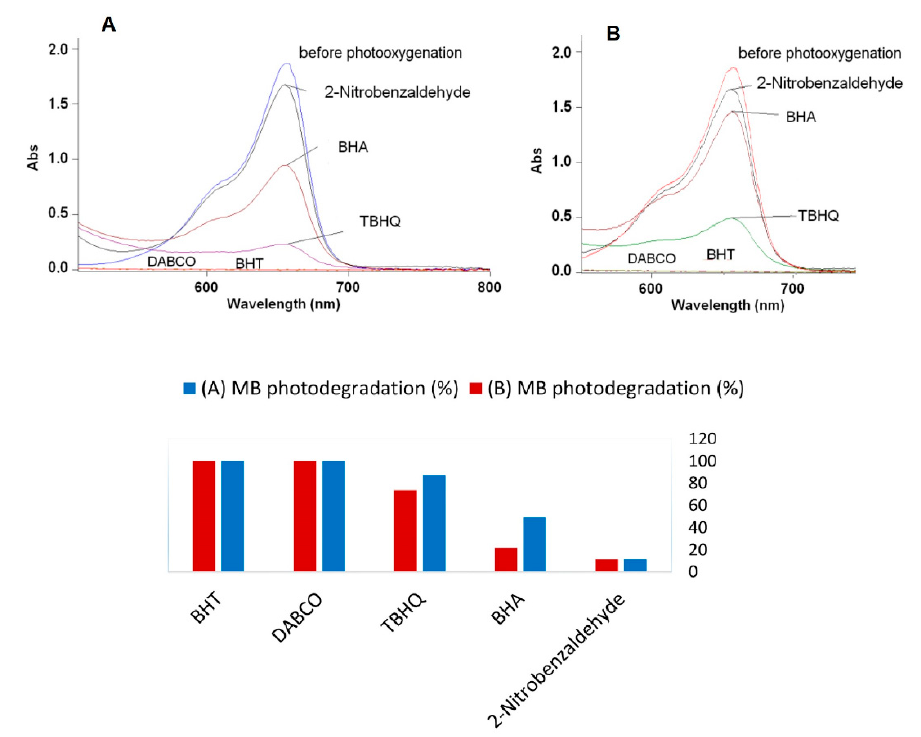
Figure 3. UV-Vis spectra and bar graph showing the degree of photodegradation of MB ( λ max = 655 nm) in the presence of different kinds of antioxidants after 24 h of irradiation with 16 fluorescent lamps ( λ = 300 nm). Antioxidant concentrations: ( A ) 1 mmol DABCO, BHA, BHT, TBHQ, and 2-nitrobenzaldehyde. ( B ) 0.5 mmol DABCO, BHA, BHT, TBHQ, and 2-nitrobenzaldehyde.